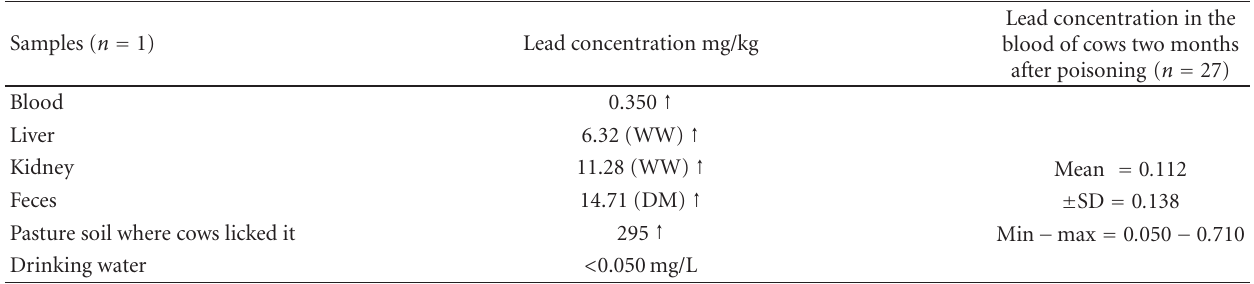
Table 5: Lead concentration in soil of pasture, drinking water, blood, liver, kidney, and feces of one dead cow, and mean ± SD ( n = 27) and min-max blood lead concentration in cows from the farm with acute lead poisoning two months after